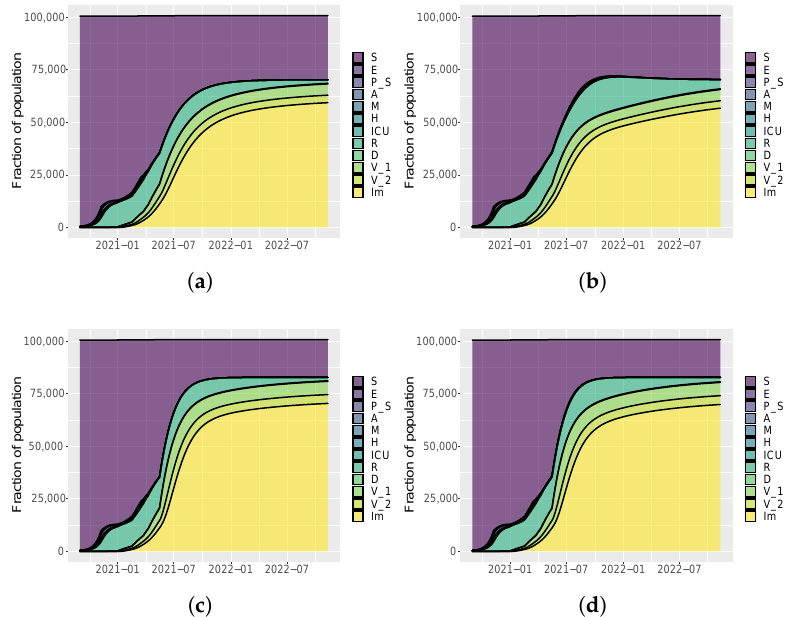
Figure 14. Area plots of model variables to compare the long-term evolution of the epidemic dynamics in Italy. ( a ) 500,000 first doses every day and low values for b e and b 0 (Low/Low). ( b ) 500,000 first doses every day and high values for b e and b 0 (Low/High). ( c ) 1,000,000 first doses every day and low values for b e and b 0 (High/Low). ( d ) 1,000,000 first doses every day and high values for b e and b 0